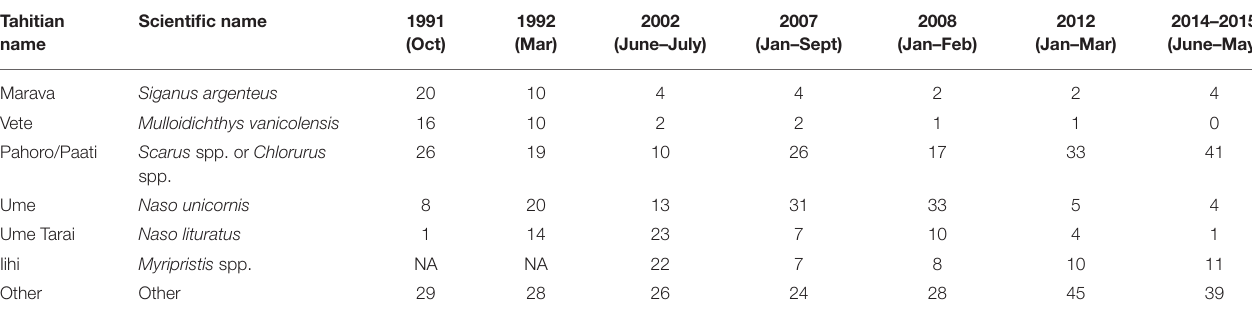
TABLE 2 | Relative abundance (percent) of important fished taxa sold by the roadside on Moorea since 1991.